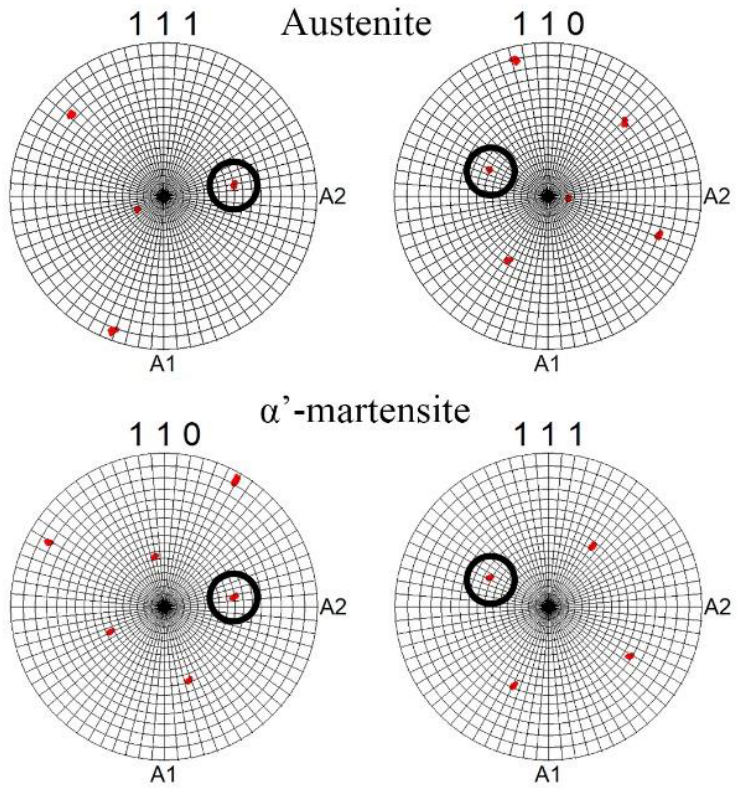
Figure 11. Typical pole figures of the austenite and α ’-martensite crystals after a 20% reduction to show the austenite– α ’-martensite relationship. The coincidences of the austenite and α ’-martensite projections are indicated by the black circles.